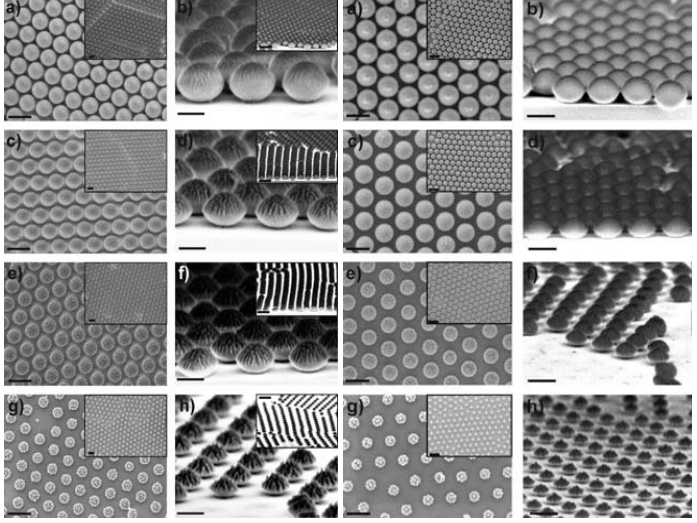
Figure 5. Making of non-closed packed polystyrene monolayer arrays by oxygen plasma etching under different etching conditions [45]. Scale bars: 200 nm, insets: 500 nm.